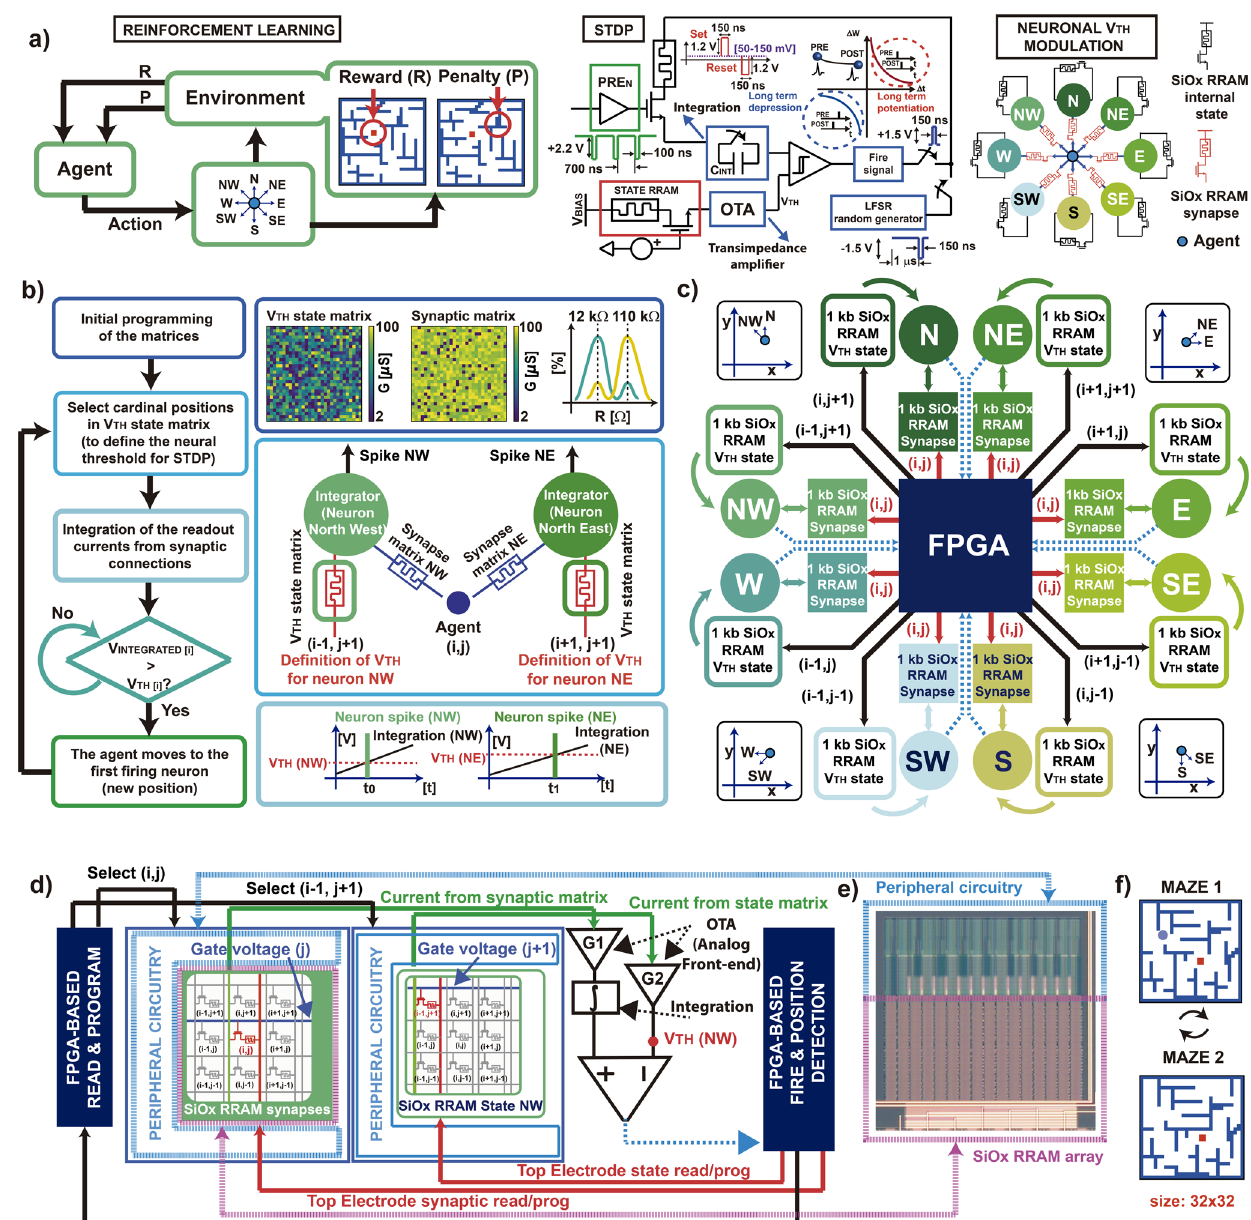
Fig. 2 | Flow-chart of the reinforcement learning procedure implemented in hardware. a Representation of high-level reinforcement learning for autonomous navigation considering 8 main directions of movement: an agent (e.g., a robot) interacts with the environment by means of decision-making events which even- tually lead to penalties or rewards that modulate the next actions. The direction of movement between two positions is ruled by the STDP. The pre-neuronal signal (currentpositionoftheagent)excitesthegateof theselectorofthesynapticRRAM element by sending a sequence of rectangular pulses while the TE of the synapse is biased at a read voltage (between 50 and 150mV). The consequent post-synaptic current is integrated in the post-neuron and compared with the internal threshold (ruledbyafurther “ state ” device)eventuallyinducing fi reactivitieswhichpotentiate the synaptic element and mark the direction of movement. Note also that LFSR